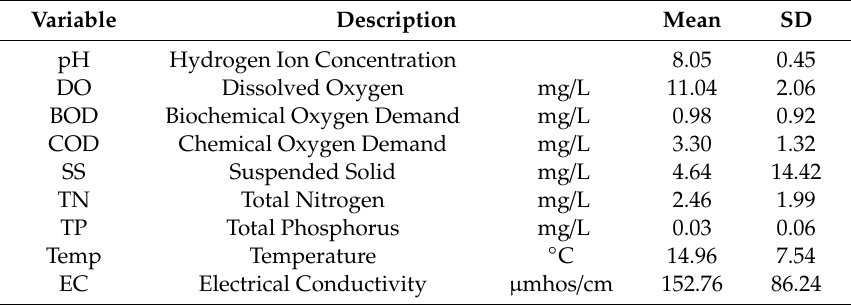
Table 2. Characteristics of variables measured for the Bukhan River.